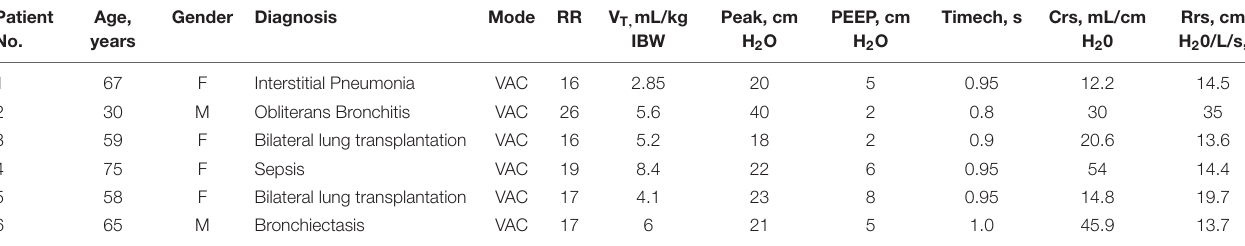
TABLE 1 | Patient’s demography, diagnosis, ventilator and respiratory mechanics. Patient No.